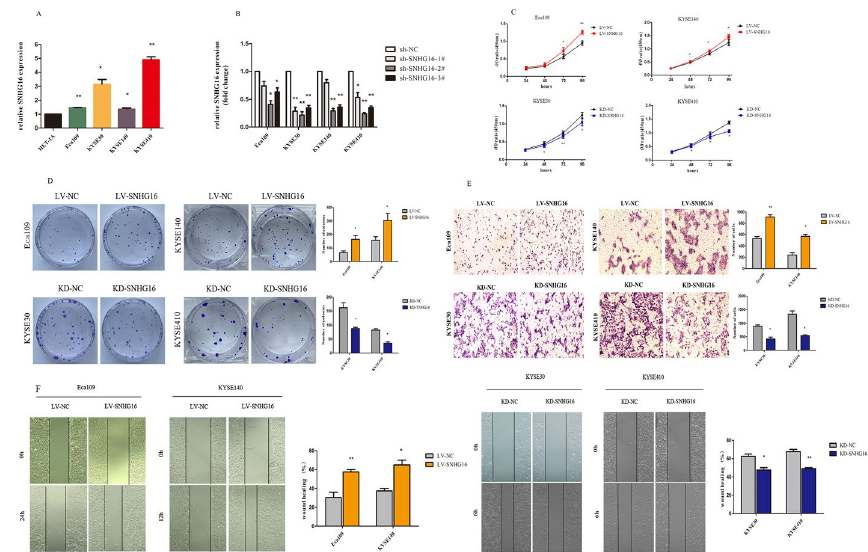
Fig. 2 The effect of SNHG16 on ESCC cell proliferation and migration in vitro. A The relative expression of SNHG16 in the normal human oesophageal epithelium cell line (HET-1A) and four ESCC cell lines (Eca109, KYSE30, KYSE140 and KYSE410). B Relative expression levels of SNHG16 in four ESCC cell lines transfected with sh-NC or sh-SNHG16 #1, #2 and #3 tested by qRT-PCR. C The effects of SNHG16 on ESCC cell proliferation ability, colony formation ability ( D ) and migration ability from Transwell assays ( E ) and wound healing assays ( F ). Error bars indicate the mean